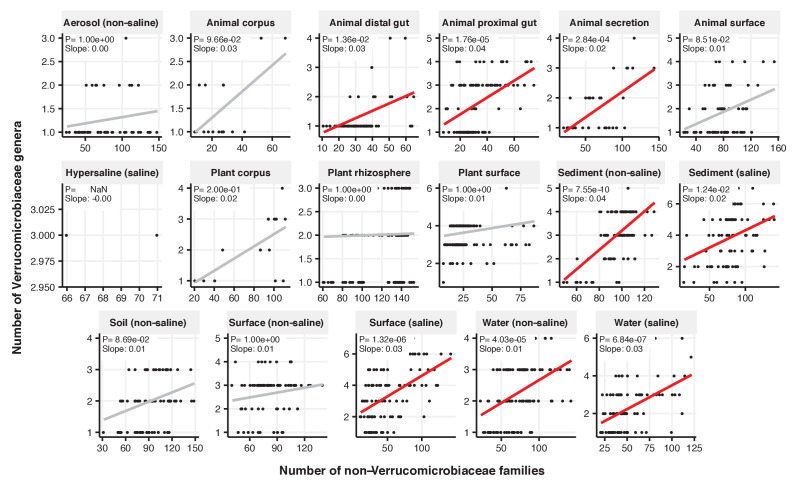
Focal-lineage diversity as a function of community diversity across biomes in Verrucomicrobiaceae.Linear models are shown for genera per family (y-axis) as a function of community diversity (non-focal families, x-axis) in each of the 17 environments (EMPO3 biomes). Only environments containing the focal lineage are shown. Significant positive diversity slopes are shown in red (linear models, p<0.05, Bonferroni corrected for 17 tests), and non-significant in grey.